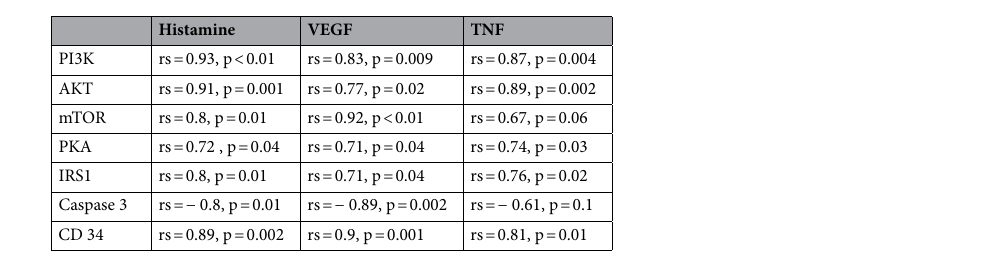
Table 5. Statistical correlations between mast cell mediators (histamine, VEGF, and TNF-α) and members of the PI3K/AKT/mTOR pathway, PKA, IRS-1, CD34 and caspase 3 in the cimetidine/vitamin c treated group.